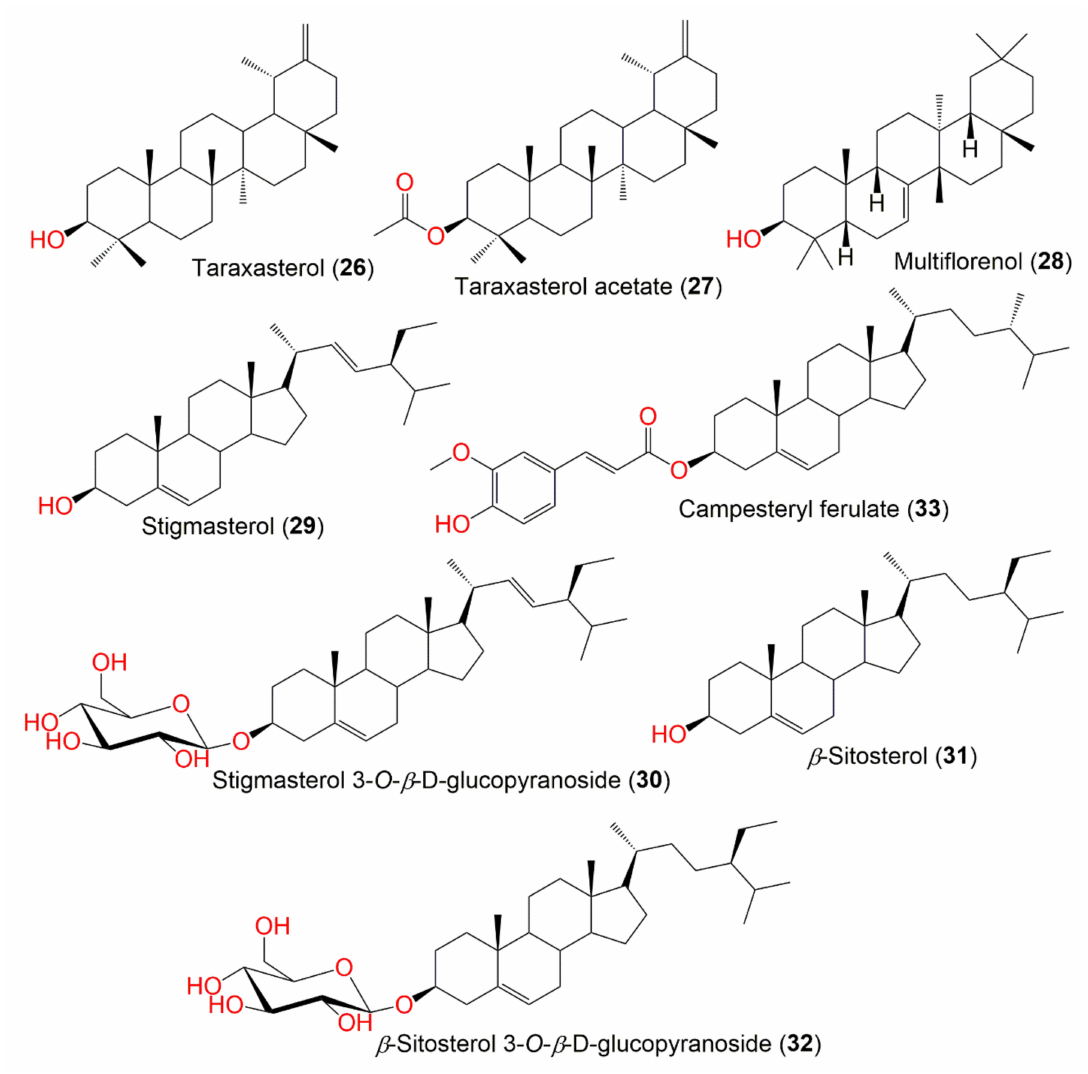
Figure 3. Structures of compounds 26 – 33